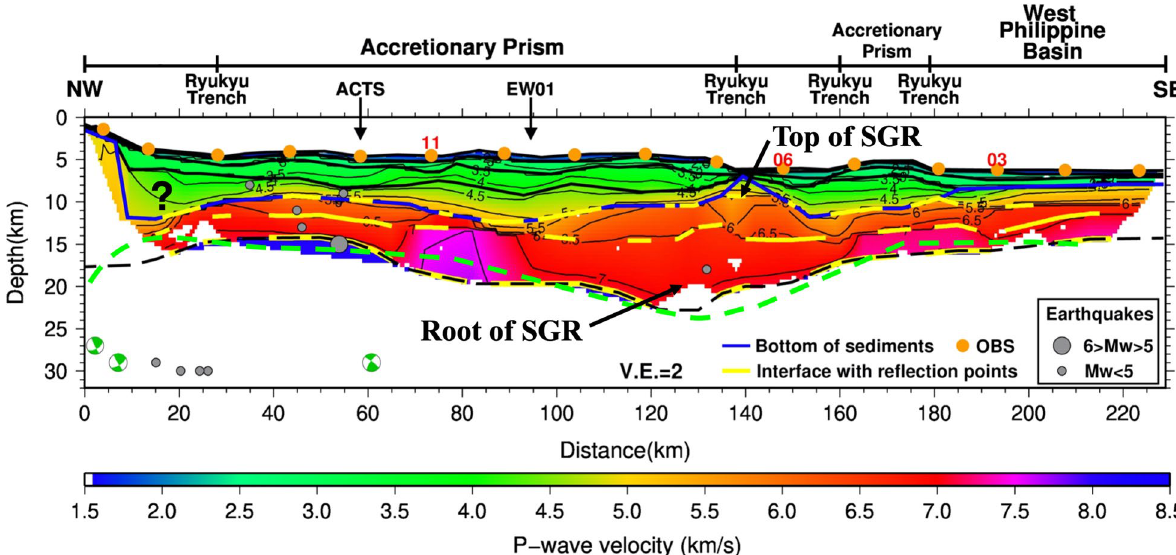
Fig. 9 The P‑wave velocity‑interface model covered by the refracted and reflected rays along MGL0906‑19. The relocated earthquakes (Font et al. 2004) are superimposed on the model. The focal mechanisms of the earthquakes (BATS) are indicated by the green (6 > Mw ≥ 5) beach balls. The black arrows show the location for the intersection of EW9509‑01 (EW01) and MGL0906‑12 (ACTS). The black dashed line shows the Moho. The Moho (defined by 7.5 km/s contour) from van Avendonk et al. (2014) is identified by the green line. SGR: Subducted Gagua Ridge